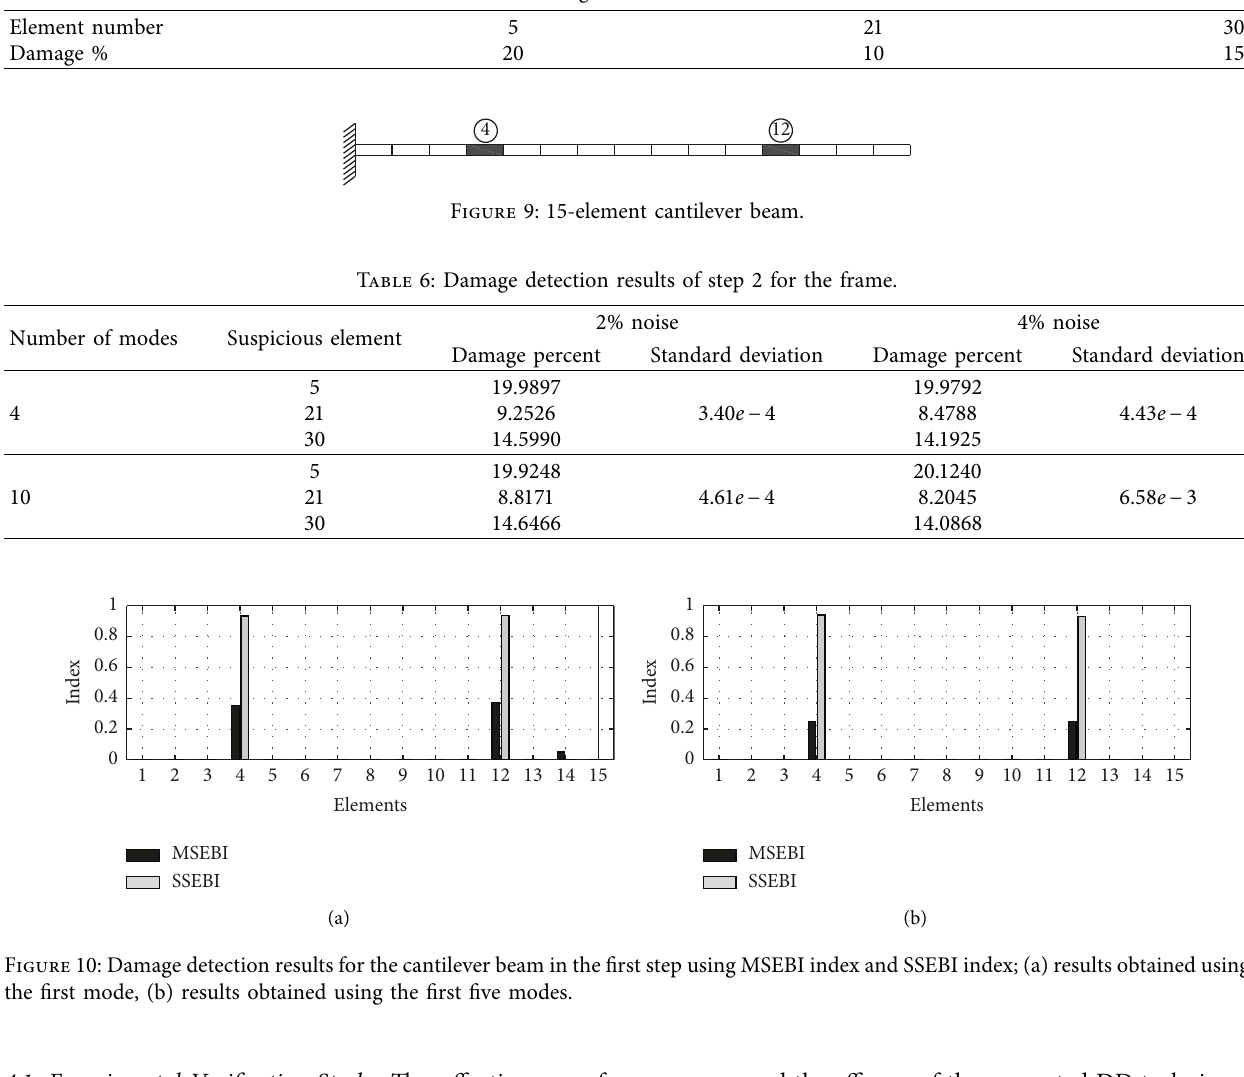
Figure 8: Damage detection results for the frame; (a) damaged locations, 2% noise, (b) damaged locations, 4% noise in measured natural frequencies. Table 5: Damage scenario for the frame.